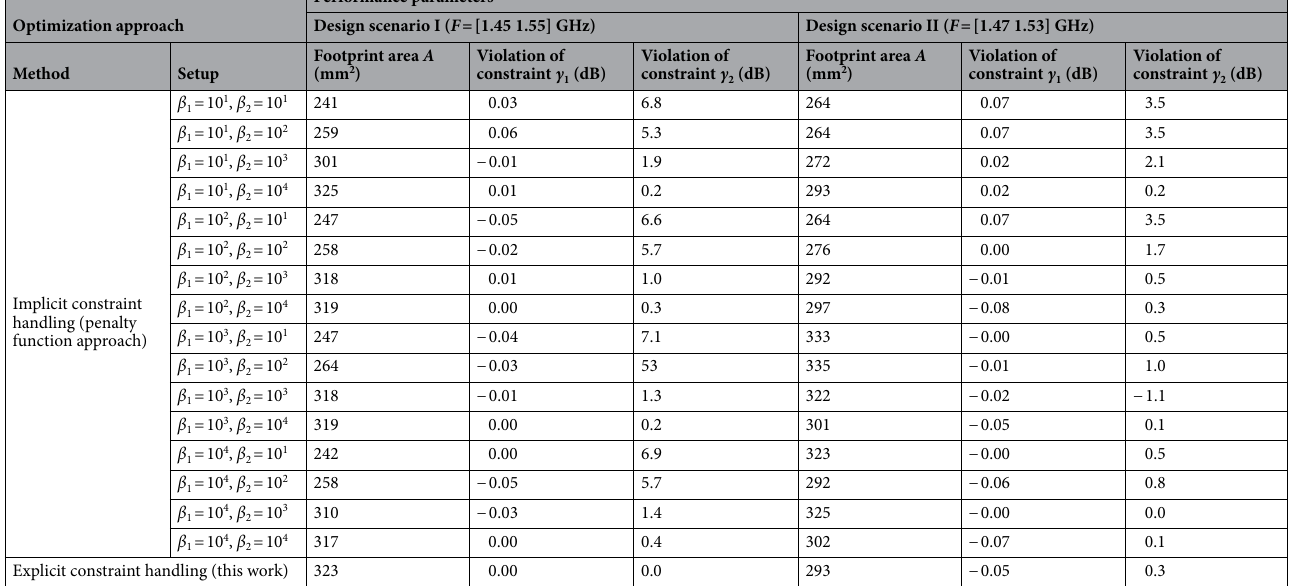
Table 2. Optimization results for Circuit I.